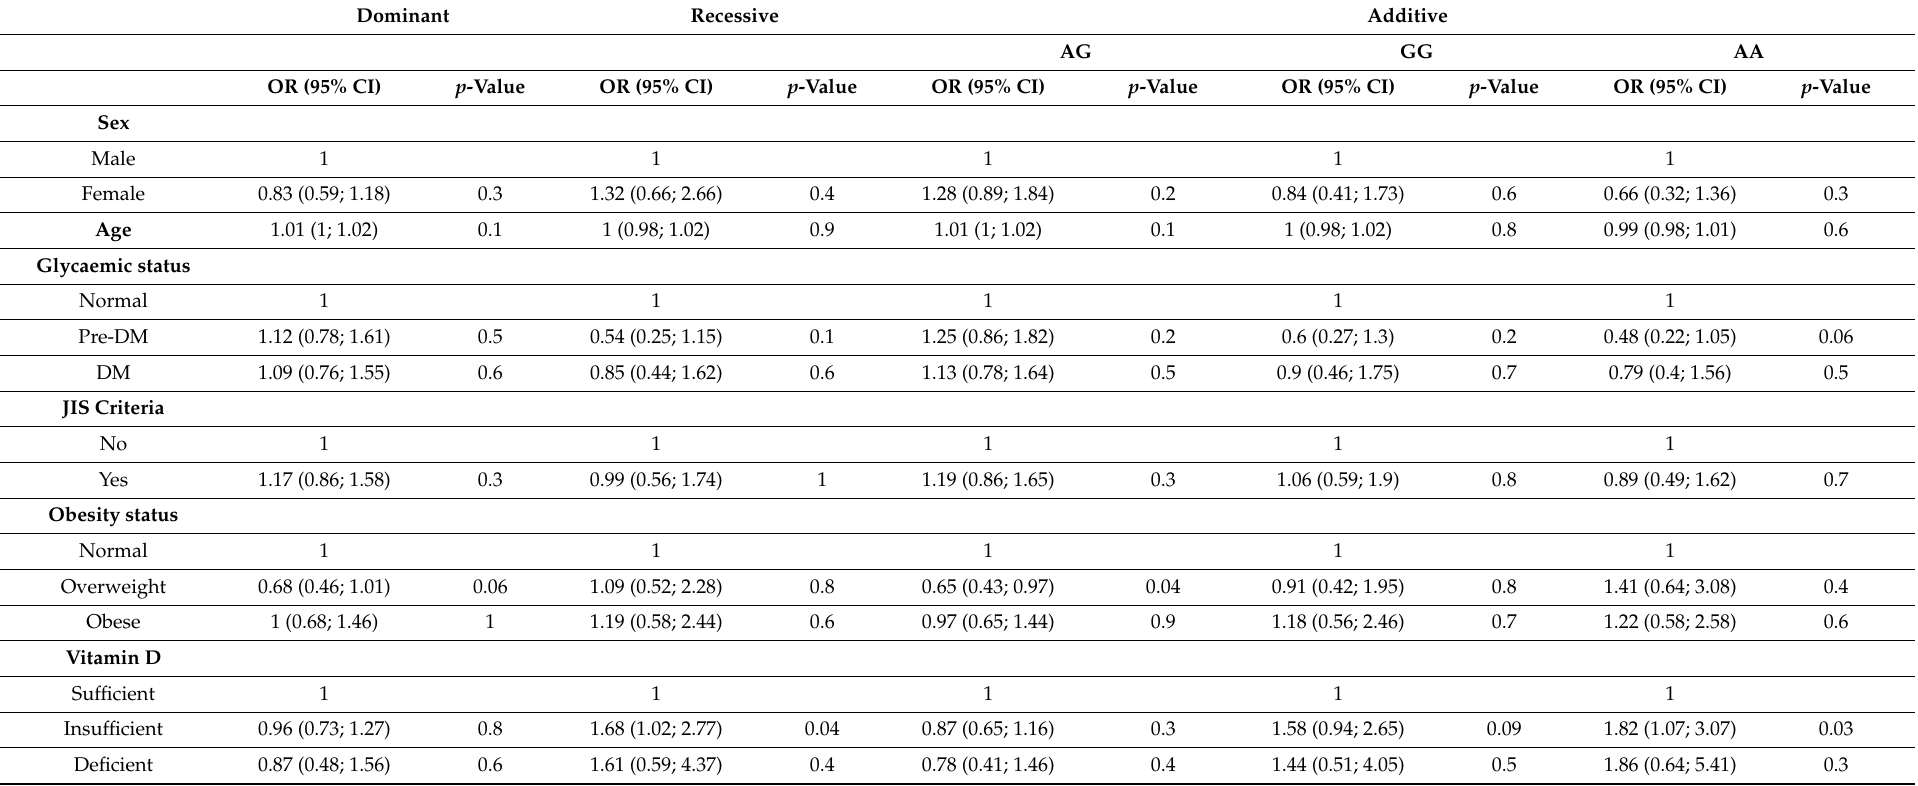
Table 6. Logistic regression for dominant, recessive, and additive models for single-nucleotide polymorphisms rs731236